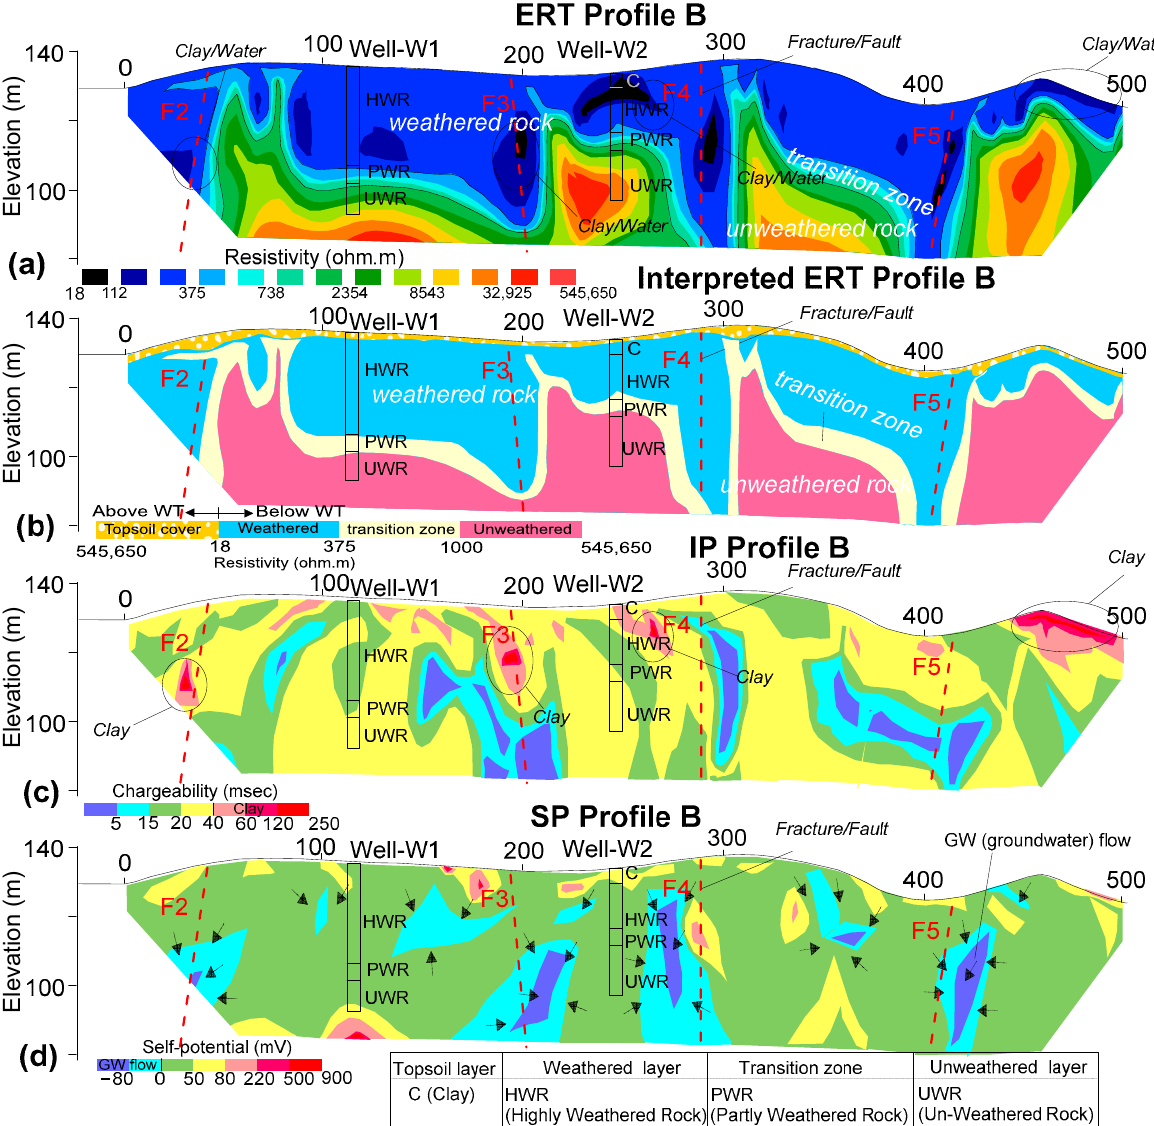
Figure 2. ( a ) 2D ERT model along profile B, ( b ) 2D ERT model along the same profile B interpreted for subsurface layers and fractures/faults based on the correlation between ERT models and borehole lithological logs, ( c ) 2D IP model along the same profile B interpreted for clay and fractures/faults, and ( d ) 2D SP model along profile B interpreted for groundwater flow path and frac- tures/faults.